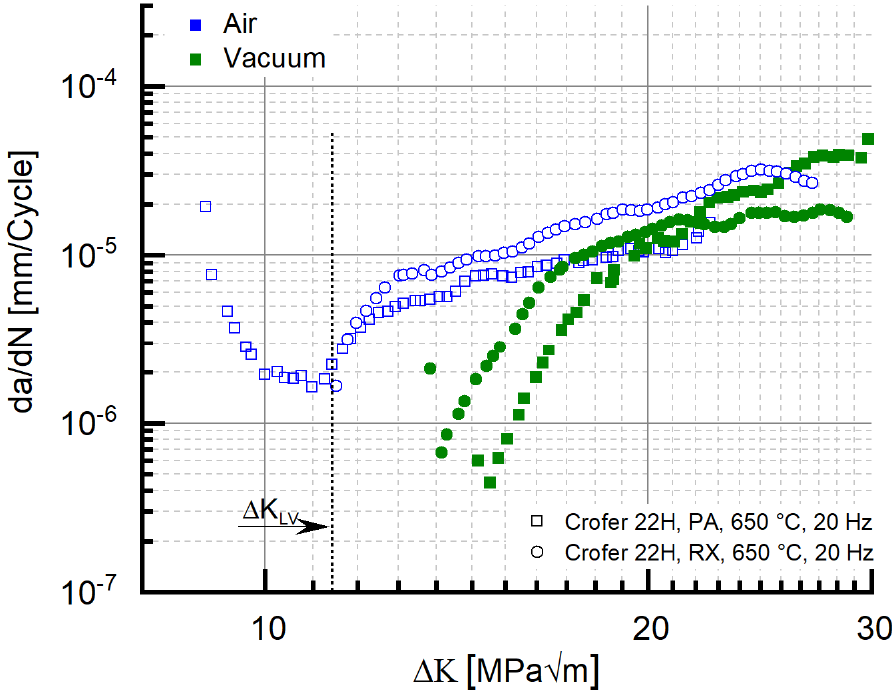
Figure 16. Identification of the limit stress intensity value Δ K LV , from which the strengthening mech- anisms cannot longer overweigh the increasing stress